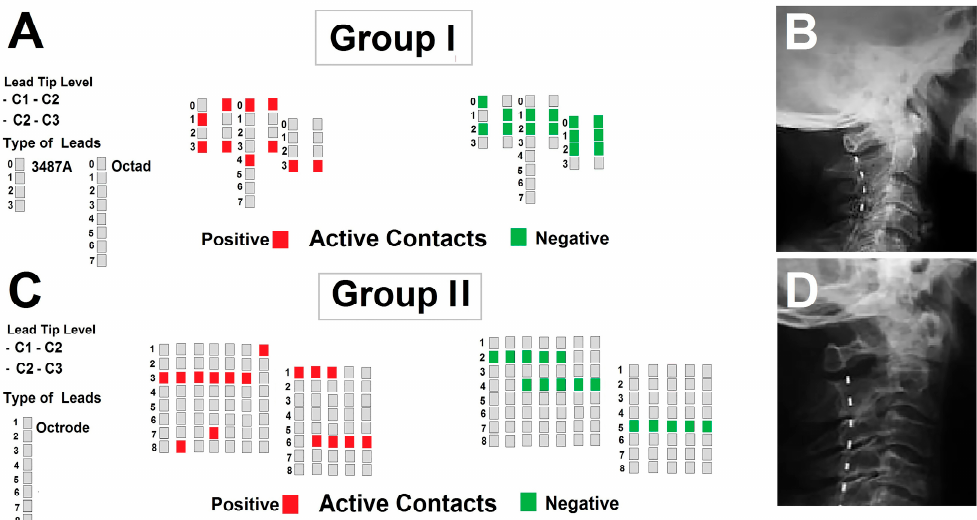
Figure 1. ( A,C ) Position of active contacts and type of electrode in Group I and Group II patients. ( B,D ) Representative examples of a quadripolar and octapolar electrode inserted at cervical level.